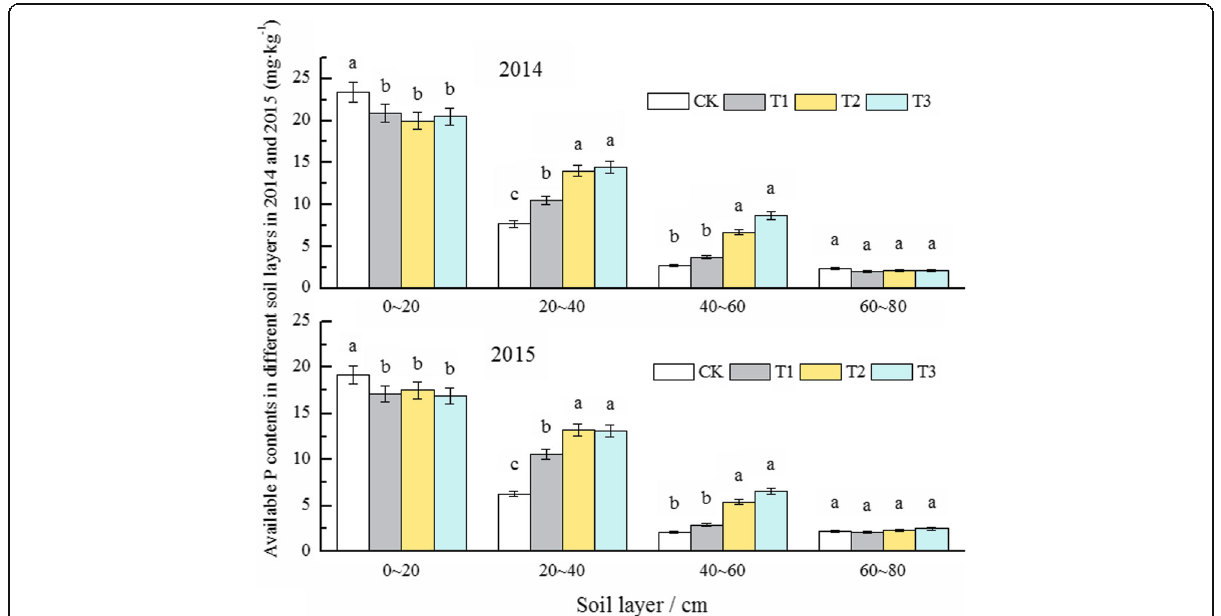
Fig. 6 Changes in available soil P contents in different soil layers in different treatments in 2014 and 2015